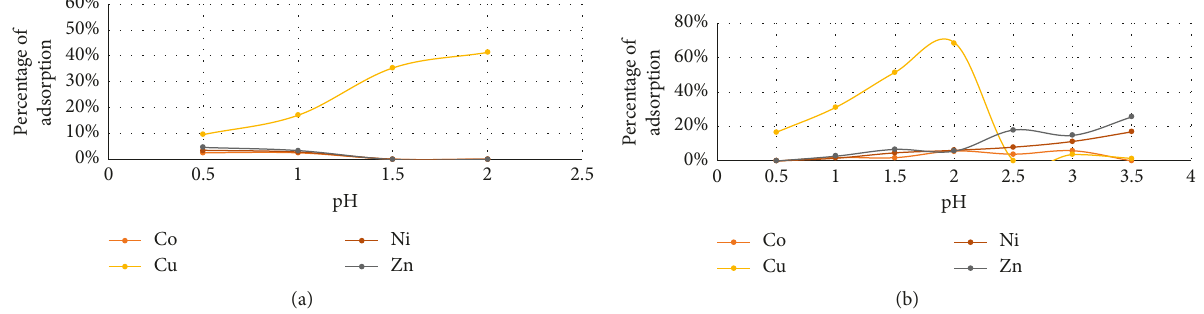
Figure 4: Effect of pH in Solution 1 by iminodiacetate resin (a) without and (b) with the pre-reducing